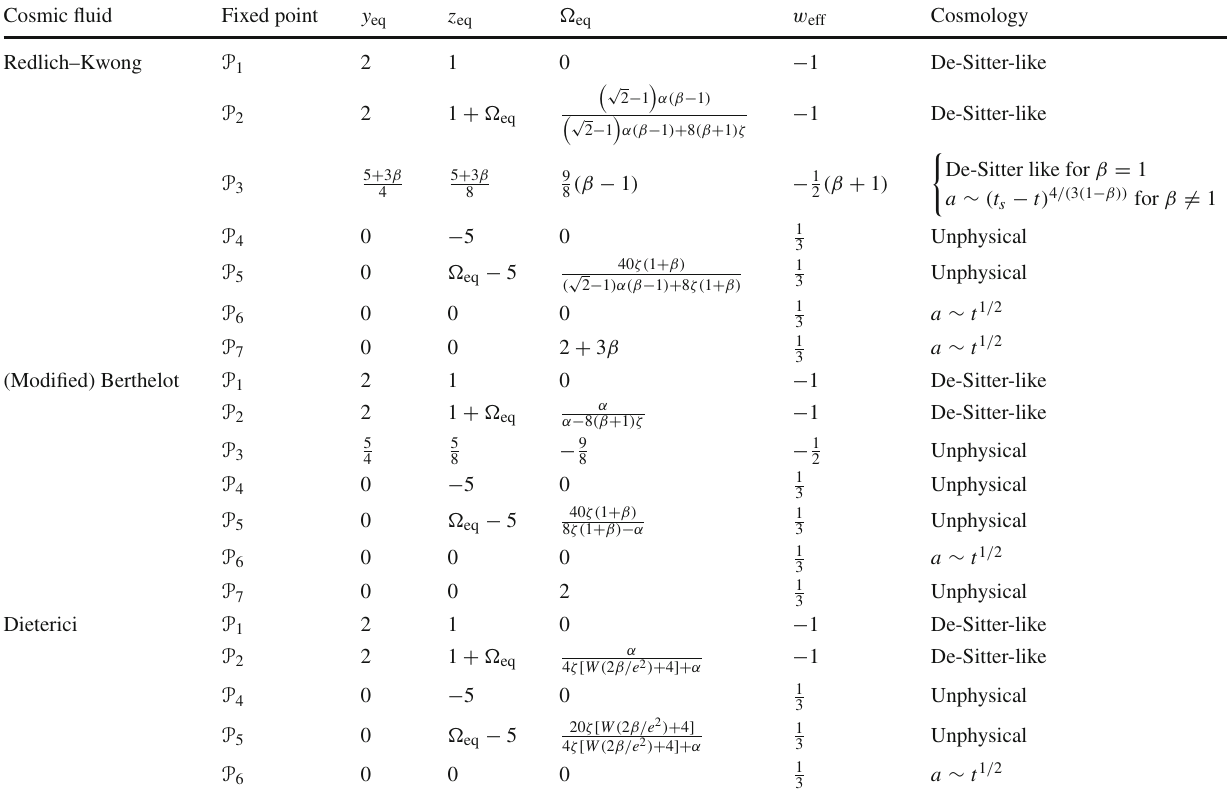
it takes into account the contributions of both the actual matter content and of the curvature effects (see also (8)). We refer to the main text for a detailed explanation of why some equilibria do not represent any meaningful cosmological model